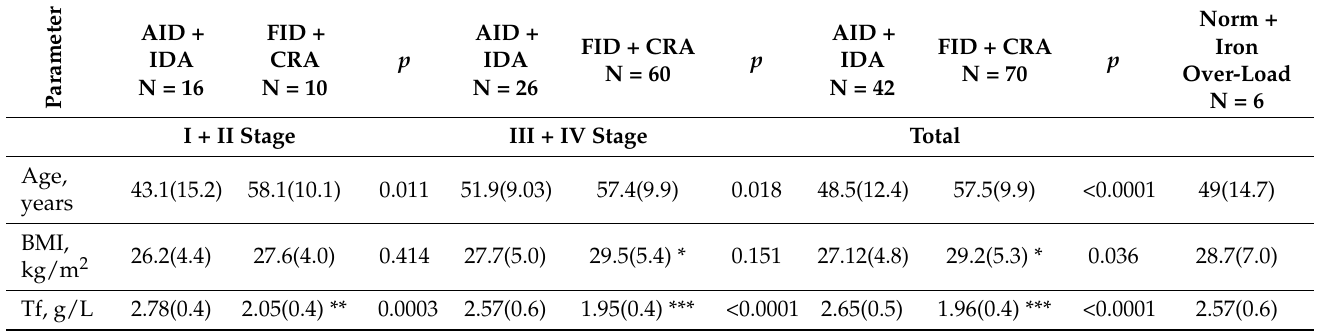
Table 2. Transferrin values in ovarian cancer patients with different iron